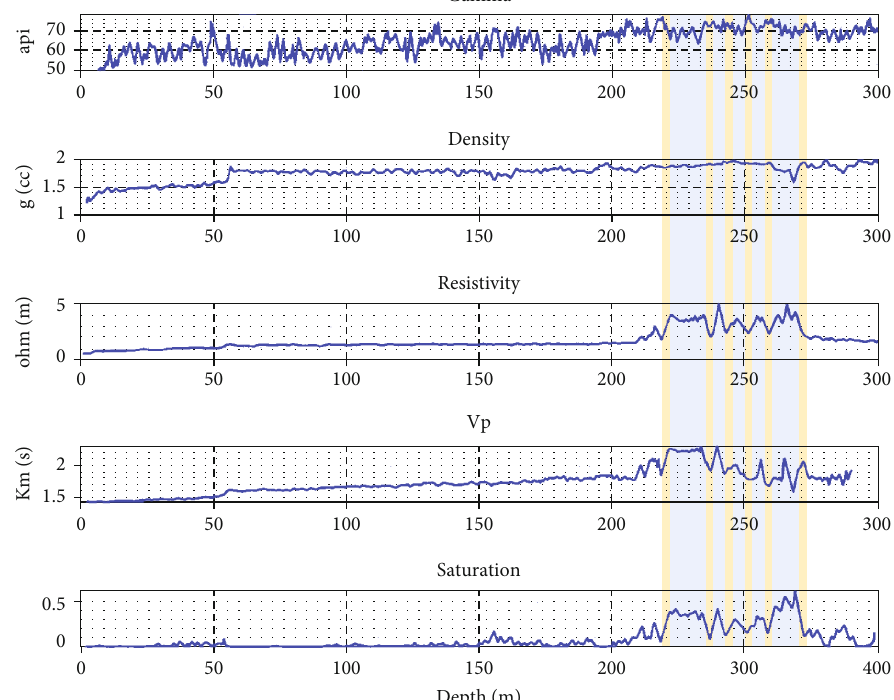
Figure 4: Curves from well SH17; the blue shaded part indicates the layer of hydrate, and the yellow shaded area indicates the nonhydrate